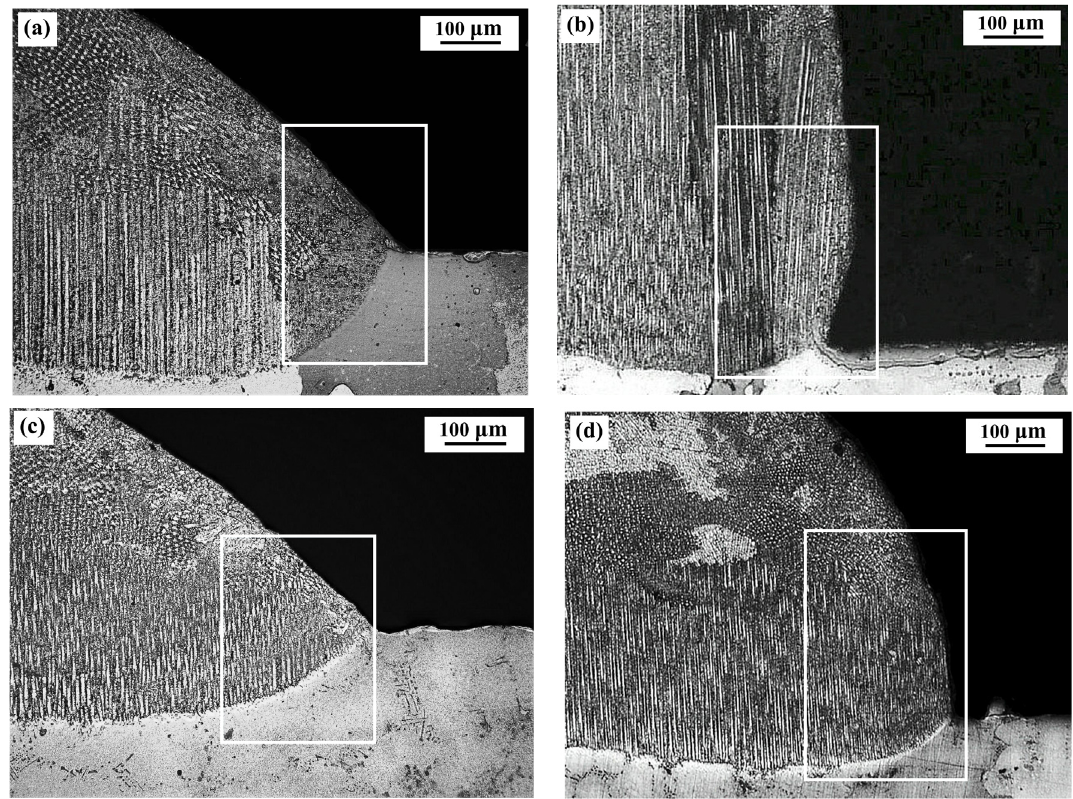
Figure 7. Columnar grains growth at edges of deposits under four different conditions (observed with an OM). (a ) CN; ( b ) CF; ( c ) SN; ( d ) SF.